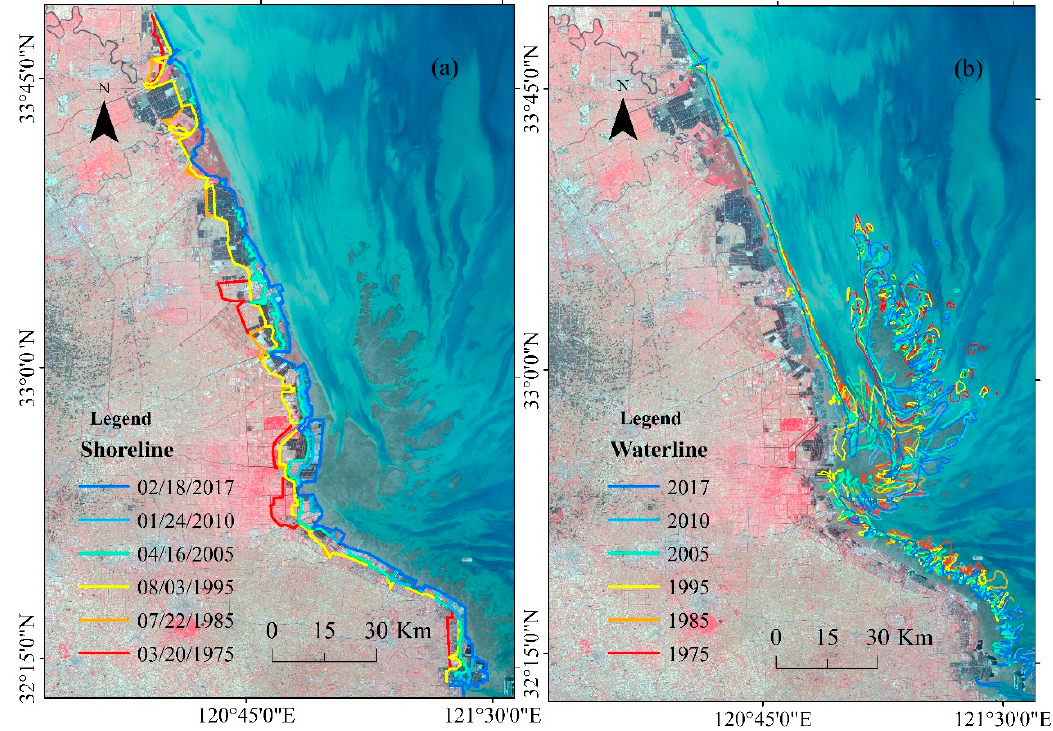
Figure 6. The changes in the shoreline and waterline during 1975–2017.